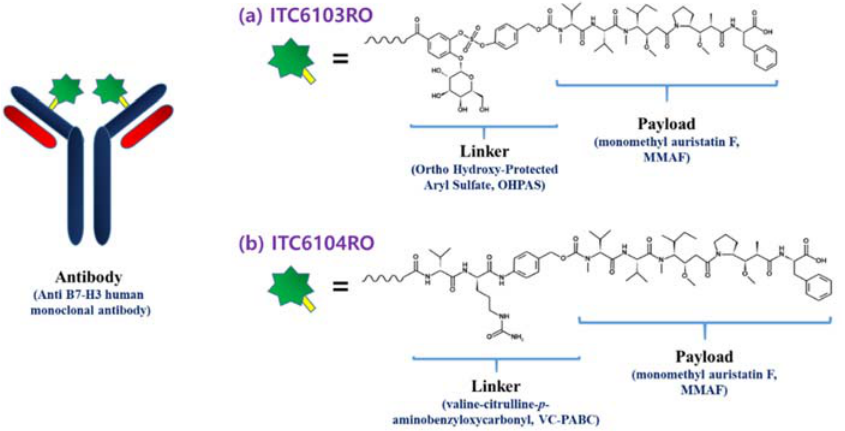
Figure 1. Structure of ( a ) ITC6103RO and ( b )